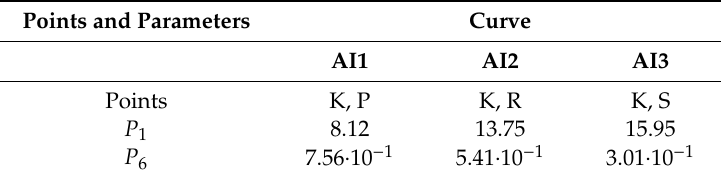
Table 23. P 1 and P 6 for the Alnico increasing curves.